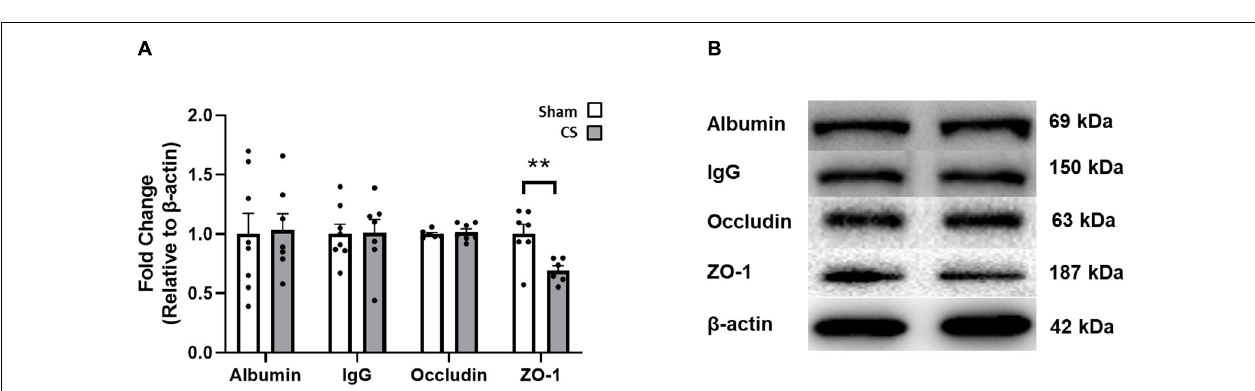
FIGURE 5 | Chronic CS exposure decreased ZO-1 protein in the hippocampus. (A) Blood–brain barrier (BBB) protein levels in the hippocampus. (B) Representative Western blot images of BBB proteins. Data was analyzed by a Student’s t -test and expressed as mean + SEM with significance being represented as ** p < 0.01. n =